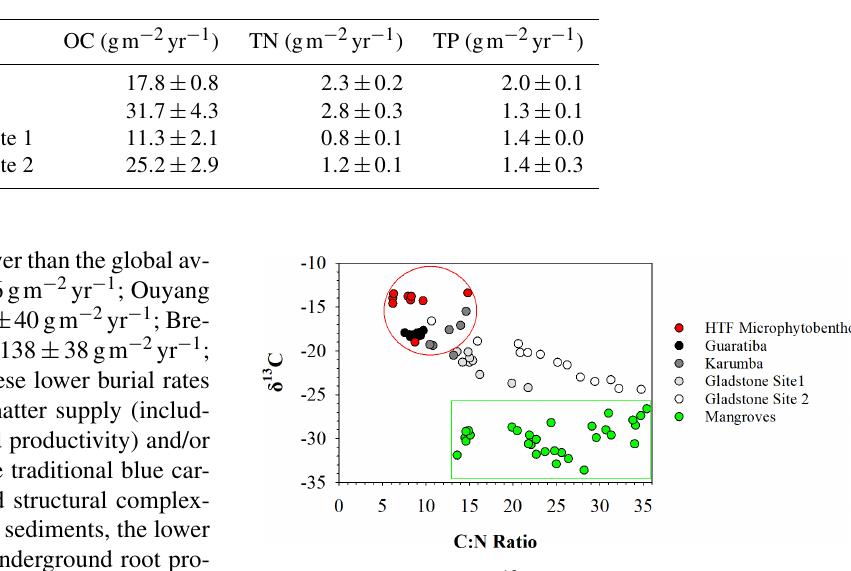
Table 2. Mean ( ± standard error) ∼ 50-year organic carbon (OC), total nitrogen (TN) and total phosphorus (TP) burial rates in the four hypersaline tidal flat sediment cores. Means are based on one core per site.